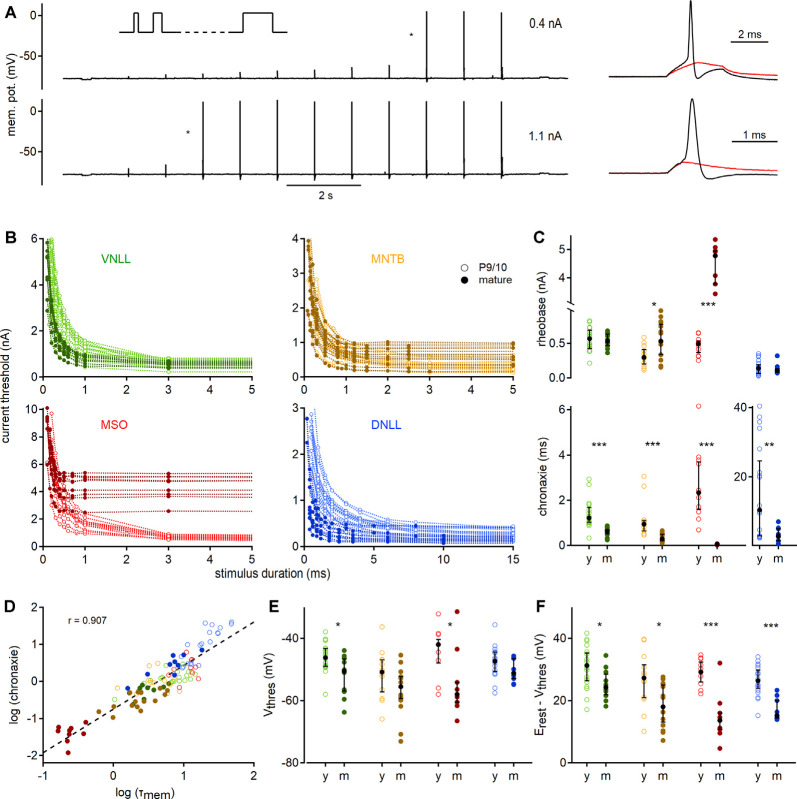
Quantification of action potential thresholds and neuronal excitability by strength-duration curves. (A) Stimulation paradigm; square currents of ascending duration (inset) were injected exemplified by a P27 VNLL neuron. In every stimulation round, the current amplitude was increased until action potentials were induced (right). Cell responses to current injections of 0.4 nA (top) and 1.1 nA (bottom) are shown. Traces on the right show zoomed stimuli from the protocols, denoted with asterisks. Red curves show the last sub-threshold, and black lines the first supra-threshold response. (B) Strength-duration curves for four nuclei in two age groups. Supra-threshold responses as a function of current intensity vs. stimulus duration. Data from P9/10 animals are shown as open symbols with a light color, from mature neurons as filled symbols. (C) Rheobase (top) and chronaxie values (bottom) extracted from strength-duration curves. (D) Correlation between chronaxie and membrane time constant (τmem, r = 0.907). The regression line is shown as a dotted line. (E) Voltage threshold (Vthres). (F) Potential (between Vthres and Vrest) that needs to be crossed to reach the voltage threshold. Cell numbers per nucleus and age group, markers, and color-coding as in Figure 2. Black symbols median with first and third quartiles. *p < 0.05, **p < 0.01, ***p < 0.001.